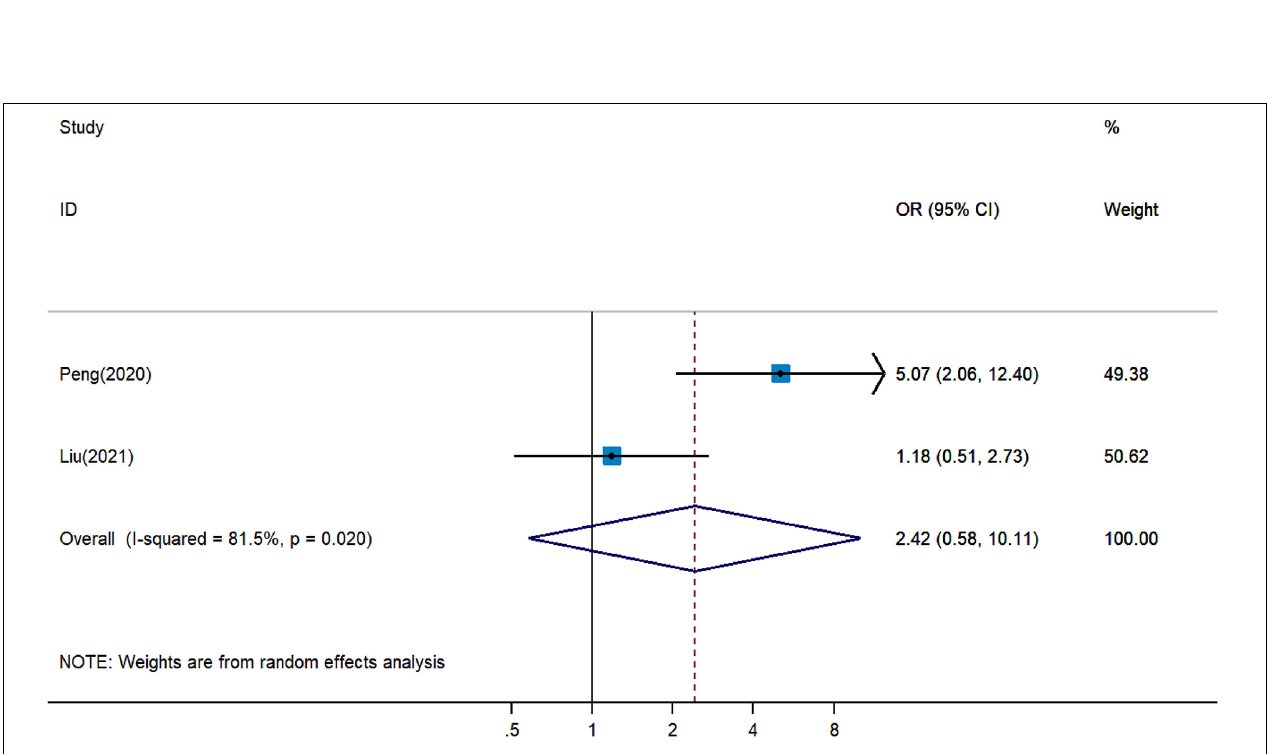
FIGURE 8 | Funnel plots of studies on the association between PLR and progressive-free survival in patients treated with immune checkpoint inhibitors.